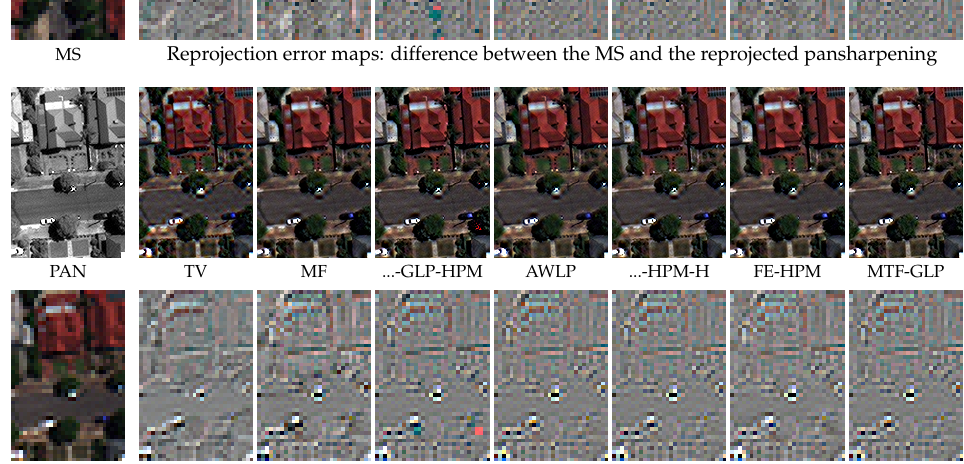
Figure 11. Sample crops from a WV3 sample image (Adelaide) and related full-resolution pansharpening. For each crop, in addition to the PAN and MS components ( left-most column), the best-performing solutions according to R- Q 2 n are shown from left to right in decreasing order, next to the PAN. For each method, both the R- Q 2 n and D ρ scores are reported on the bottom lines of the figure. Moreover, next to the MS, for each pansharpening result, the corresponding reprojection error map is